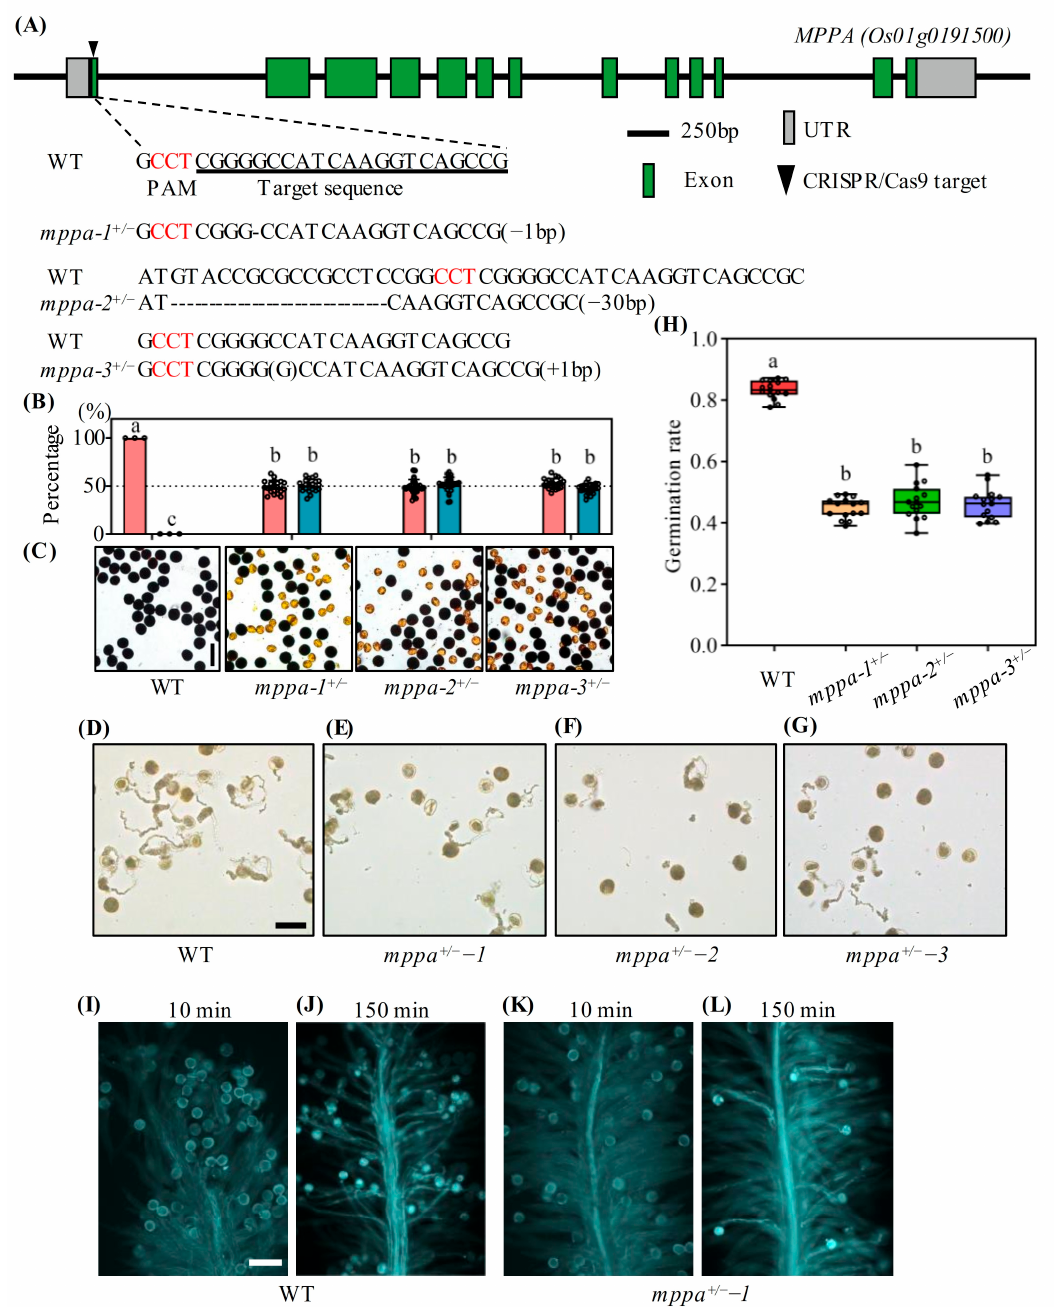
Figure 3. Dysfunction of MPPA leads to defects in pollen fertility. ( A ) Schematic diagram of MPPA (upper panel) and the genotypes of corresponding CRISPR/Cas9 mutant lines (lower panel) for the following study. The letters in red indicated the PAM site. ( B ) Percentage of fertile and sterile pollens in WT and three mppa +/ − heterozygotes. The same letter indicates a lack of significant difference using the Tukey–Kramer multiple comparison test with one-way analysis of variance (ANOVA) between groups, p < 0.05 was considered significant. ( C ) 1% I 2 -KI staining of pollen grain from WT and three mppa +/ − heterozygous mutant lines. Bar = 50 µ m. ( D – G ) In vitro pollen tube germination of wild type rice ( D ) and mppa +/ − heterozygotes ( E – G ). Bar = 50 µ m. ( H ) The germination rate of wild-type rice and different mppa +/ − heterozygotes. Fifteen individuals were counted for each line. Different letters indicate significant differences ( p < 0.0001) according to Tukey’s test (one-way ANOVA between groups). ( I – L ) Pollen eggs implanted in the stigma after selfing. The stigmas were stained with 0.1% aniline blue dye. Bar = 100 µ